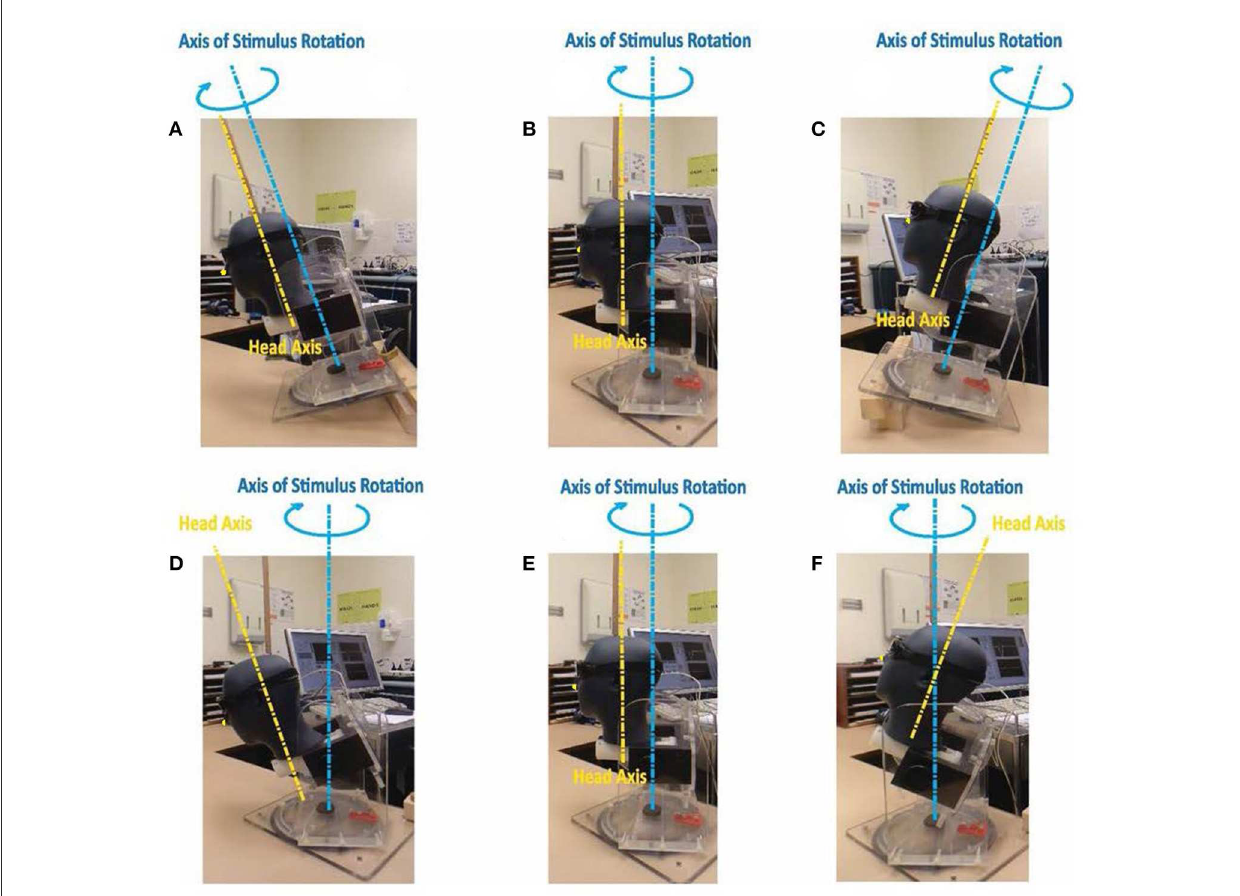
FIGURE8 Test jig for determining 3-D goggles outputs during head rotations around axes as shown. Upper row: head and jig stimulus axes aligned: (A) jig and head tilted 25 ◦ forward; (B) jig and head upright; (C) jig and head tilted 25 ◦ backwards. Lower row (D–F) jig stimulus axis earth horizontal: (D) head axis tilted 25 ◦ forward; (E) head axis upright; (F) head axis tilted 25 ◦ backwards. For impact on head velocity sensor output see Figure 9 (the nose is not clear in these figures and so we have added a small yellow dot on the nose to identify it).